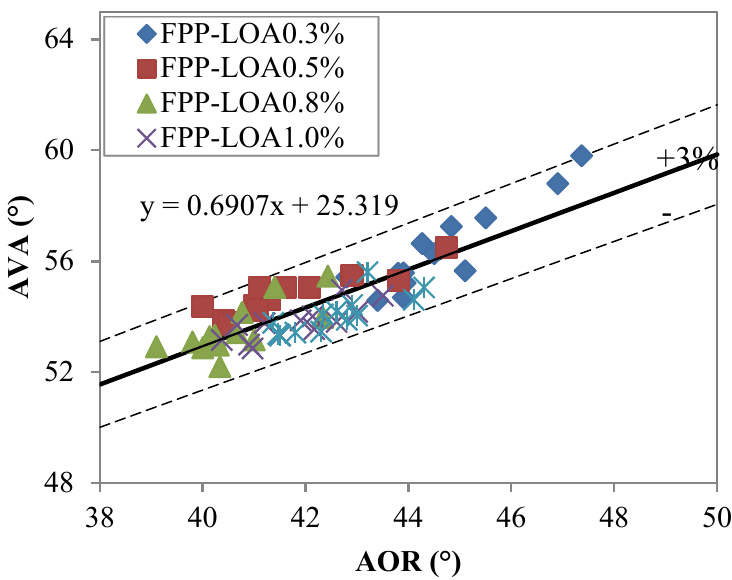
Figure 9. Correlation between semi-static and semi-dynamic flowability of fine coating powder under different LOA.